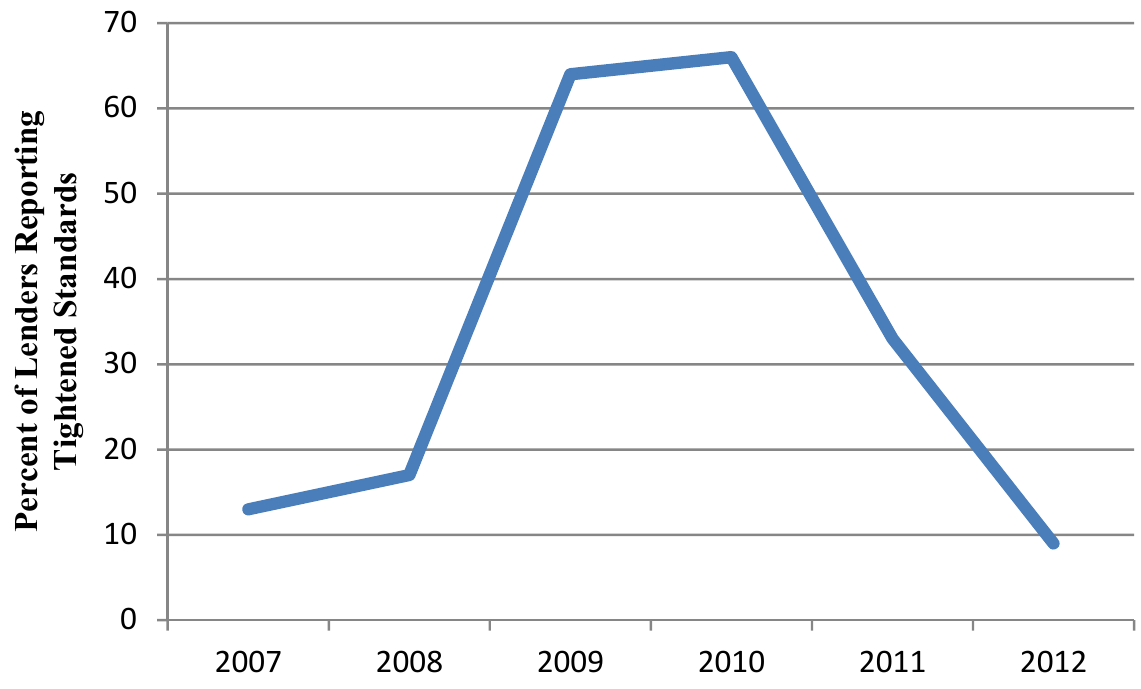
Figure 1: Tightening of Lending Standards for Small Business Loans. (From Office of the Comptroller of the Currency, “Survey of Credit Underwriting Practices” Figure 1. Tightening of Lending Standards for Small Business Loans. From Source: Office of the Comptroller of the Currency, . 2014. “Survey of Credit Underwriting Practices.” (2014: P. 35).